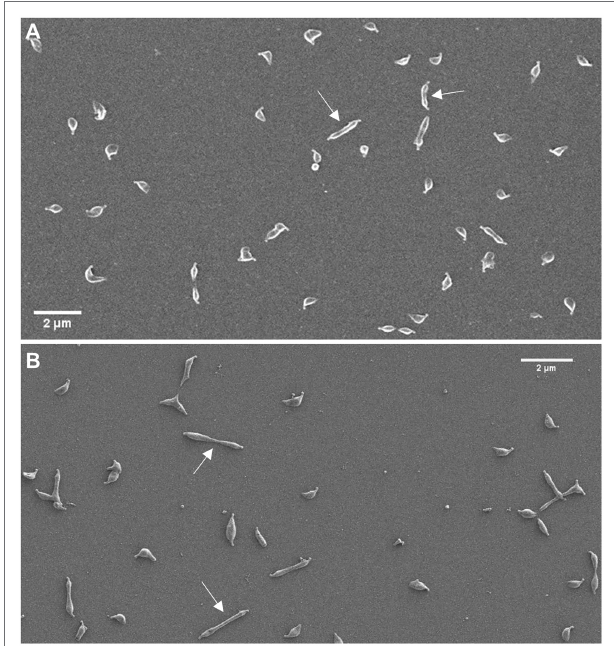
FIGURE 3 | Characterization of cell morphology of the mraZ mutant. Scanning electron micrographs of the wild-type strain (A) and the mraZ mutant (B) . White arrows indicate some cells in cytokinesis.